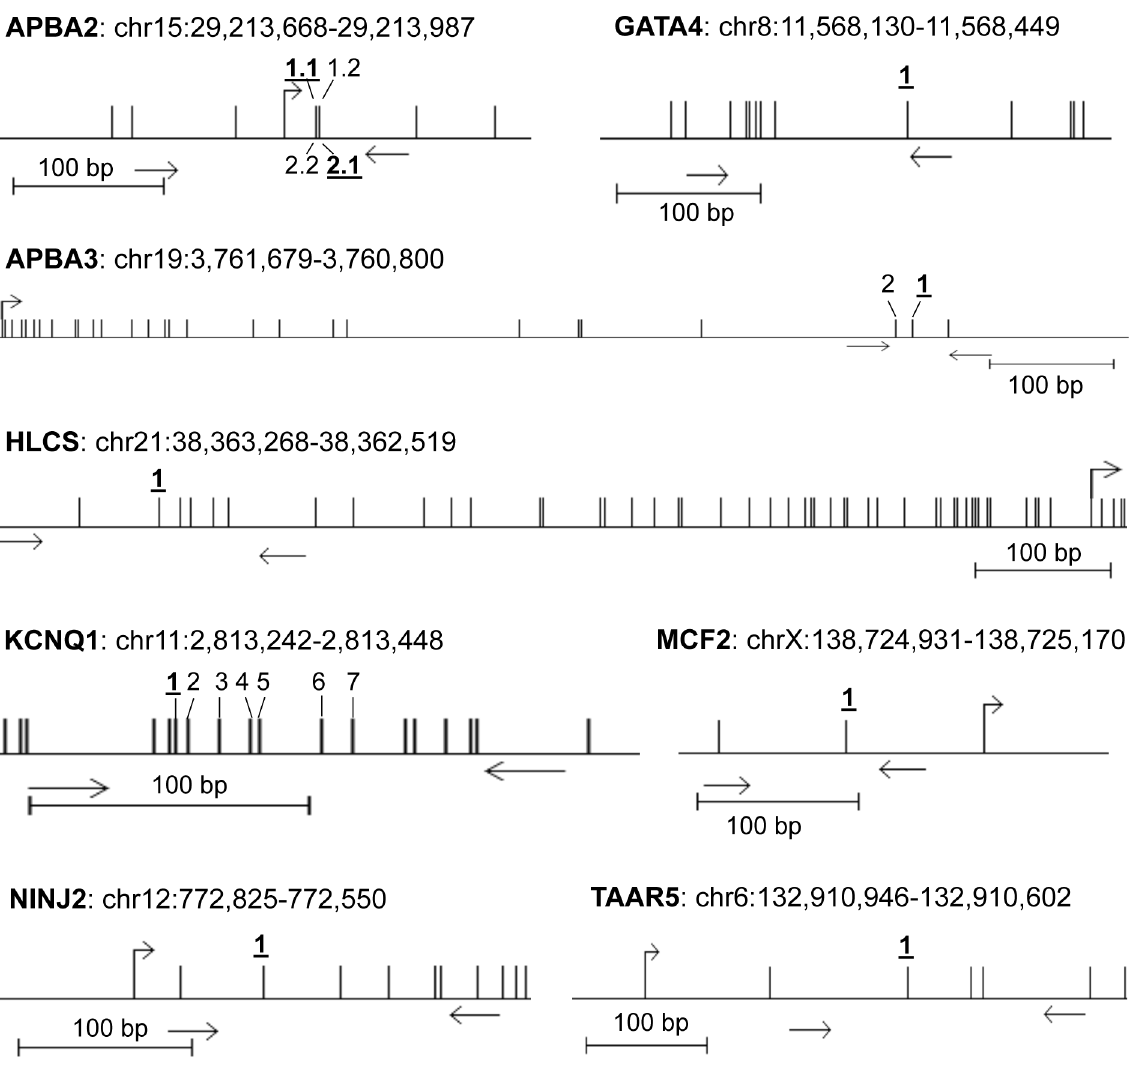
Figure 2. Map of the investigated genomic regions. Positions of the analyzed CpG sites of APBA2, APBA3, GATA4, HLCS, KCNQ1, MCF2, NINJ2 and TAAR5 are shown (http://genome.ucsc.edu). CpGs are indicated with vertical lines and the analyzed CpGs are numbered. The bold and underlined CpG sites were identified as differentially methylated in the 27K bead chip assay. Primers and transcriptions start sites are marked with arrows. Graphics were generated with the python.vs.cobra program (https://